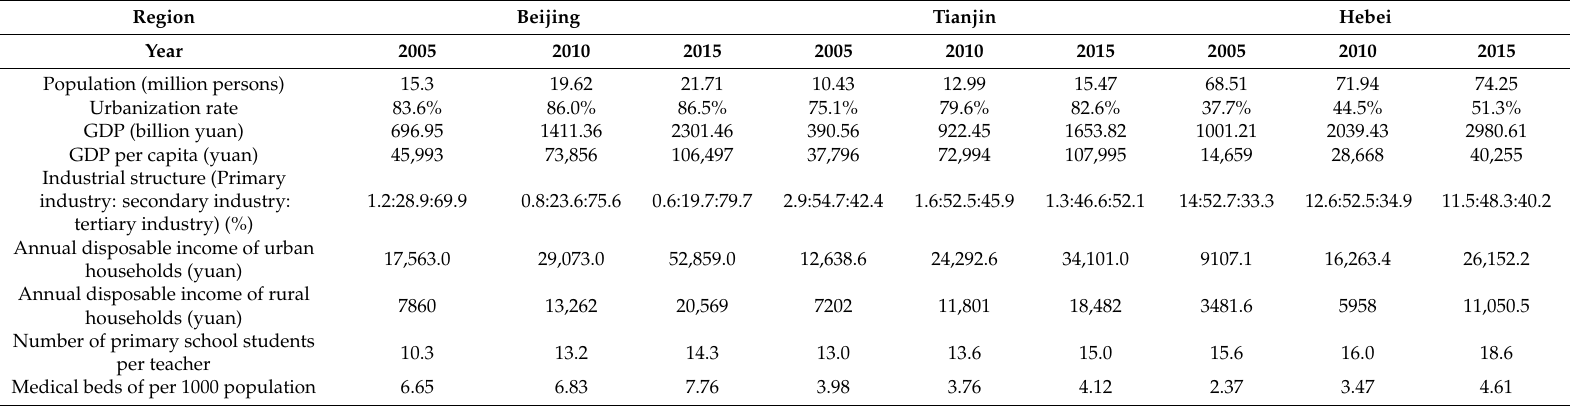
Table 2. Social-economic development of BTH. (BHT: Beijing-Tianjin-Hebei.). Region Beijing Tianjin